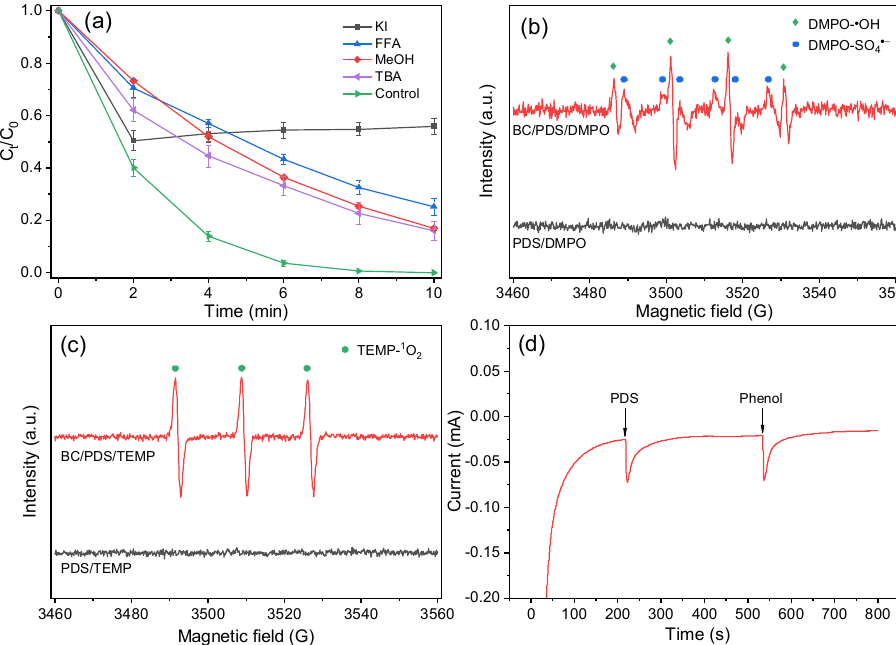
Figure 9. ( a ) Quenching effect on phenol degradation of BC-24 during PDS activation by different scavengers (catalyst dosage = 0.1 g/L, [PDS] = 0.5 mM, [phenol] = 0.2 mM, [MeOH] = [TBA] = [FFA] = [KI] = 10 mM). EPR spectra of PDS activation by BC-24 with the addition of ( b ) DMPO and ( c ) TEMP as spin-trapping agents. ( d ) Chronoamperometry test with the addition of PDS and phenol.